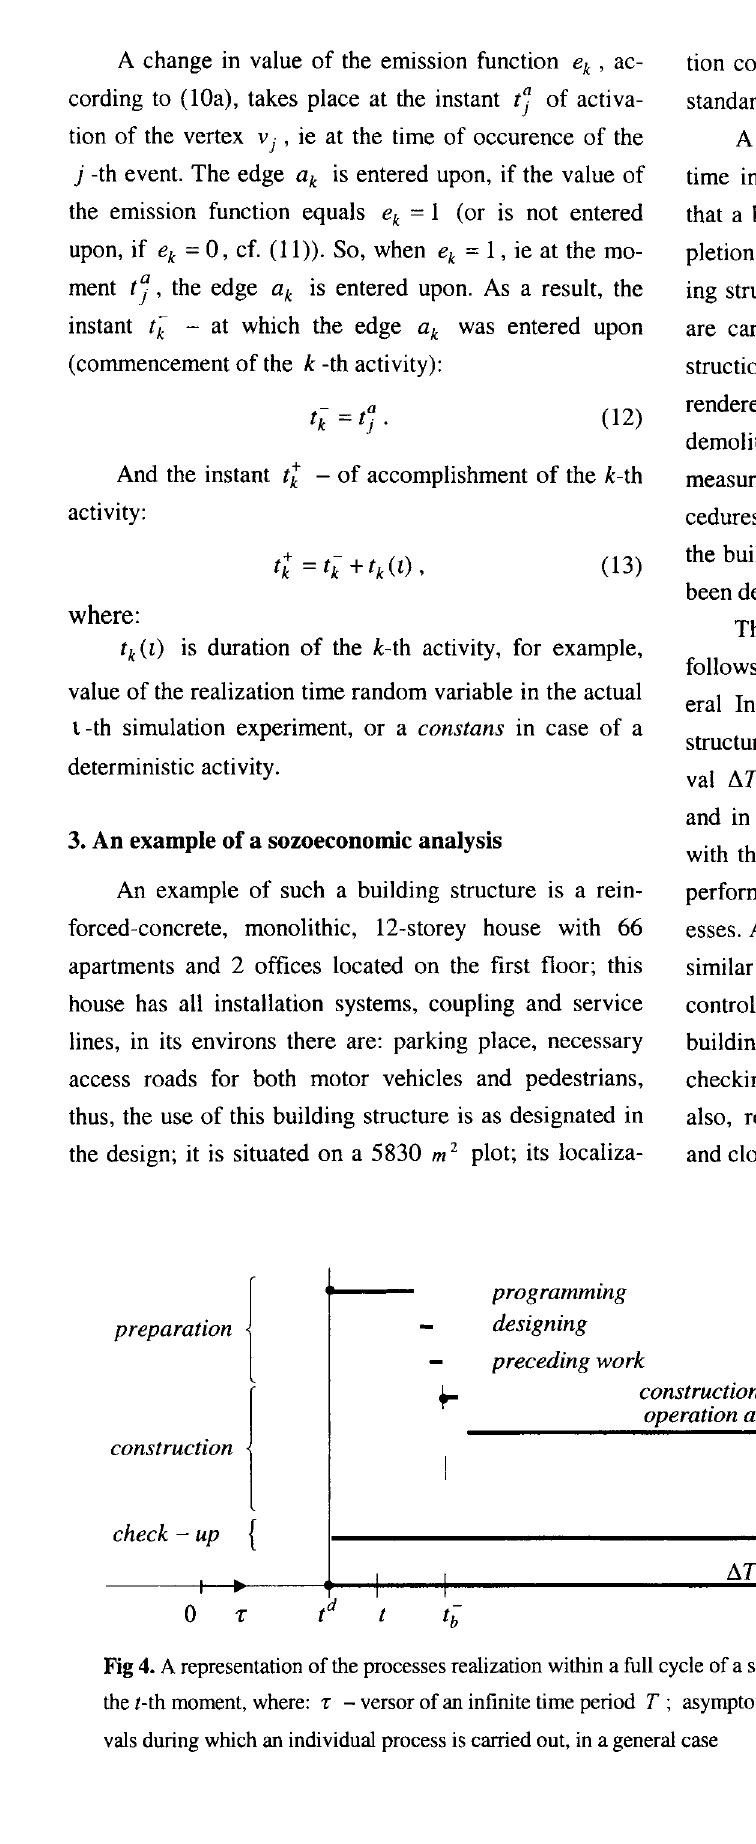
7 , t g , limit time inter